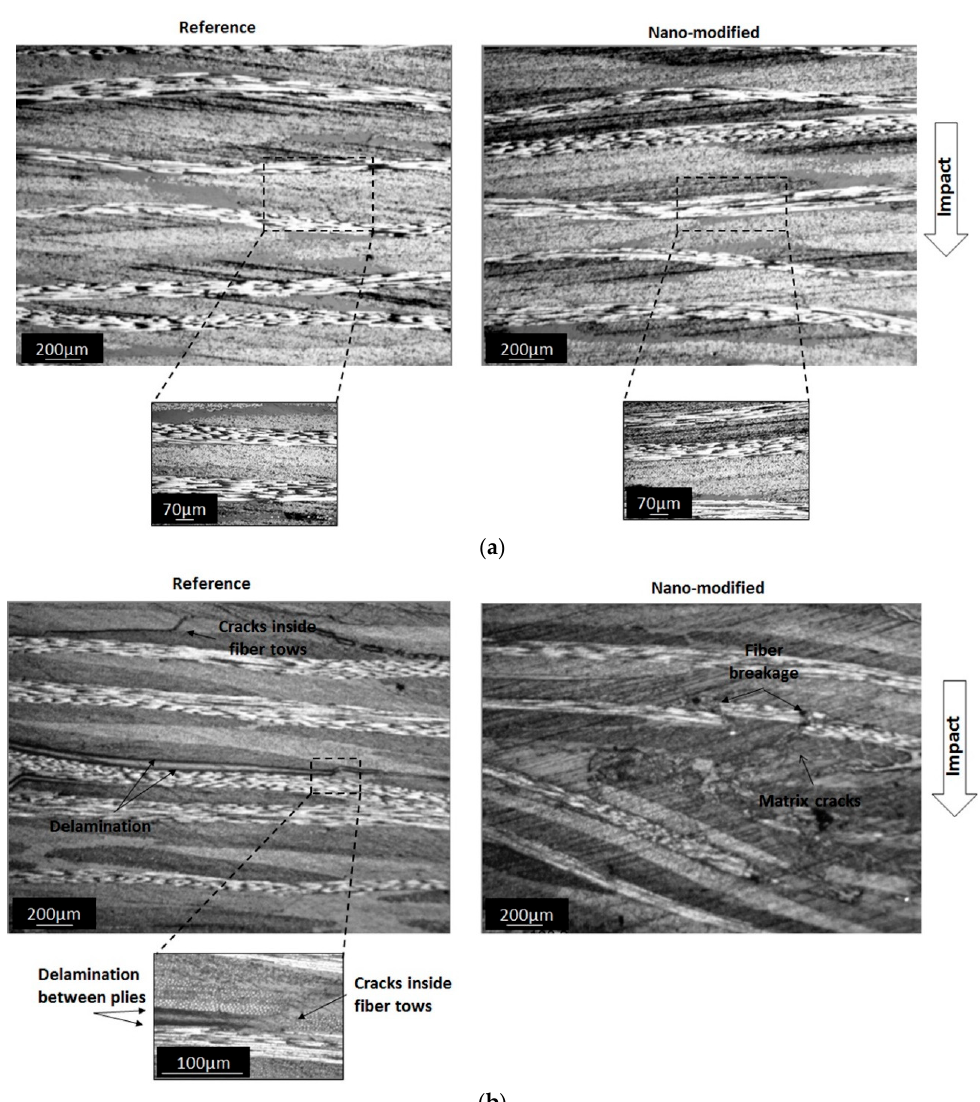
Figure 8. Optical microscope images ( a ) after impact and ( b ) after CAI of reference and nano ‐ modified enriched with 1.5 wt.% MWCNTs specimens at the centre area of impact and at an energy level of 8 J.